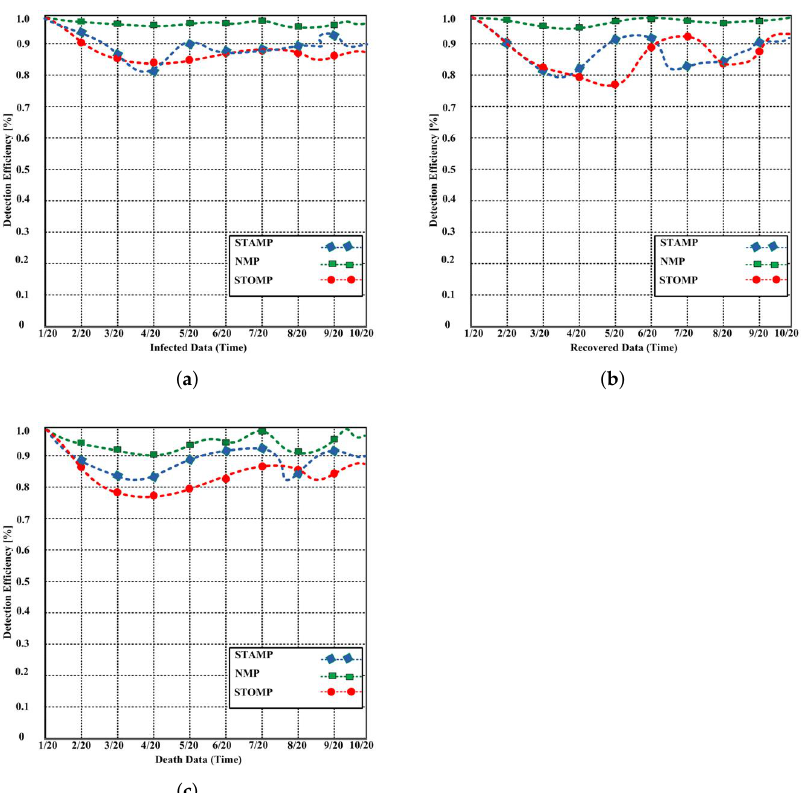
Figure 6. ( a ) Detection efficiency of the proposed NMP and contending STAMP and STOMP algorithms with patient’s infected data. ( b ) Detection efficiency of the proposed NMP and contending STAMP and STOMP algorithms with patient’s recovered data. ( c ) Detection efficiency of the proposed NMP and contending STAMP and STOMP algorithms with patient’s death